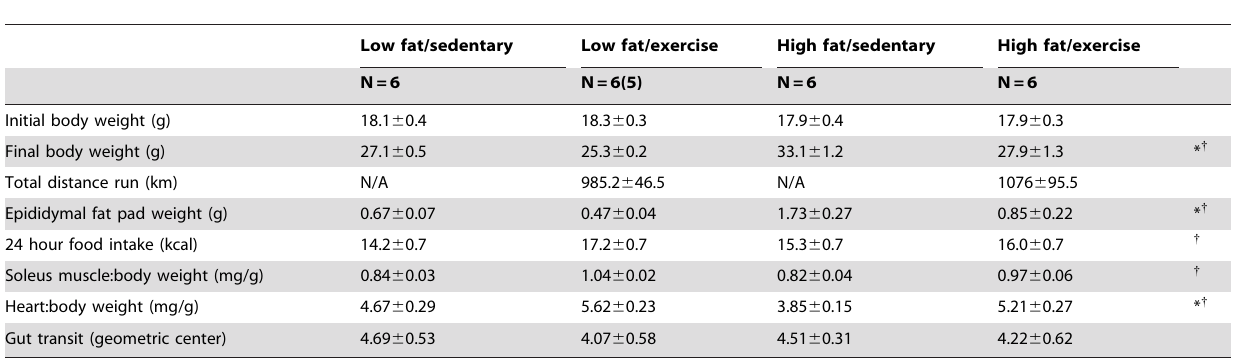
Table 1. Body and fat weight, exercise distance, food intake, heart and muscle weight and gut transit.